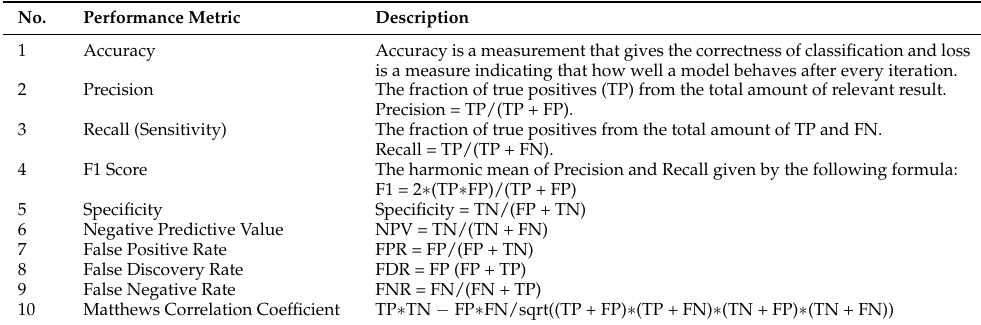
Table 3. Performance metrics